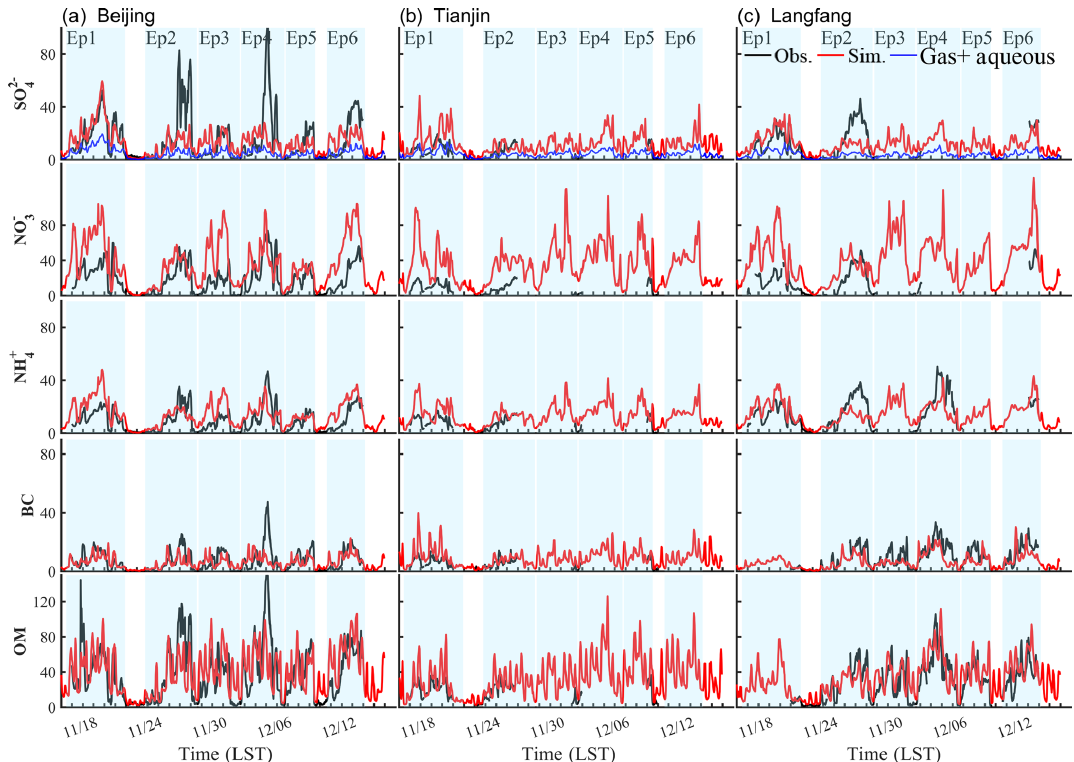
Figure 3. Comparison between the simulated (red) and observed (solid black) hourly components including sulfate (SO 2 − ammonia (NH + ), black carbon (BC), and organic matter (OM) at (a) Beijing, (b) Tianjin, and (c) Langfang. Blue lines refer to sulfate 4 produced by gas and aqueous chemistry